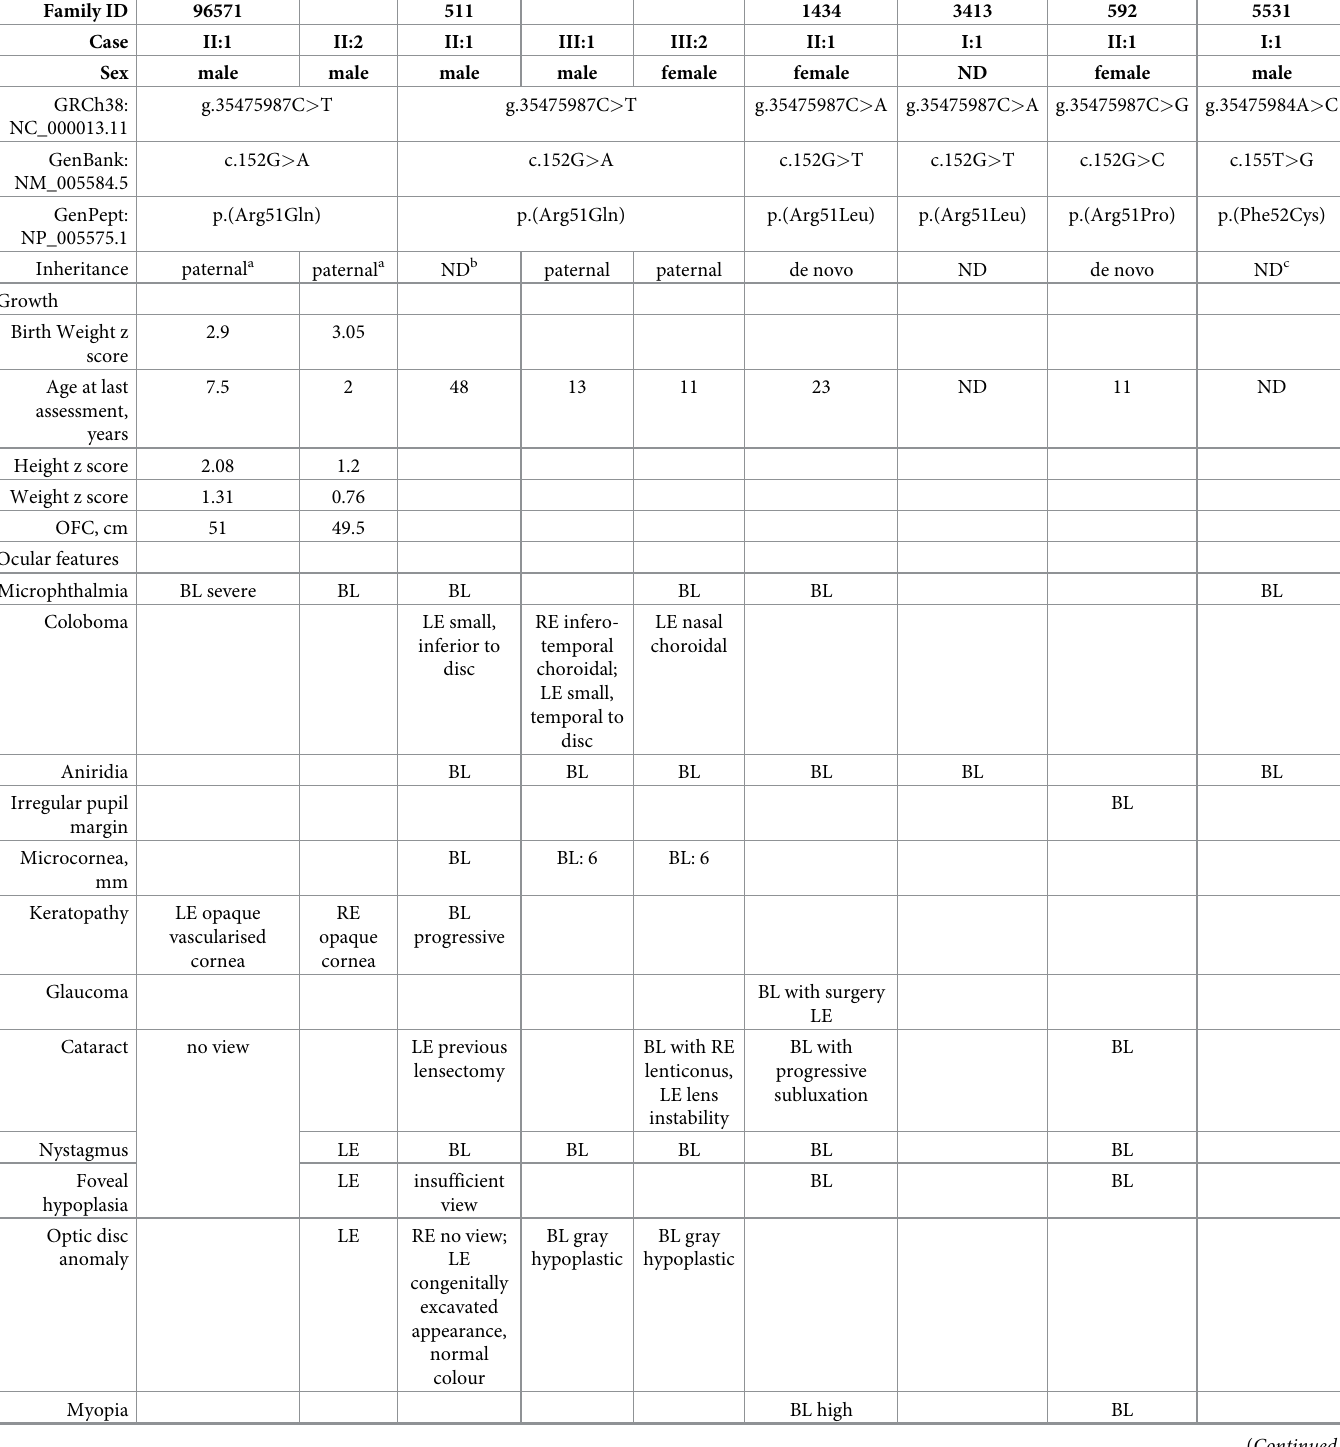
Table 1. Clinical and molecular features of individuals with MAB21L1 heterozygous